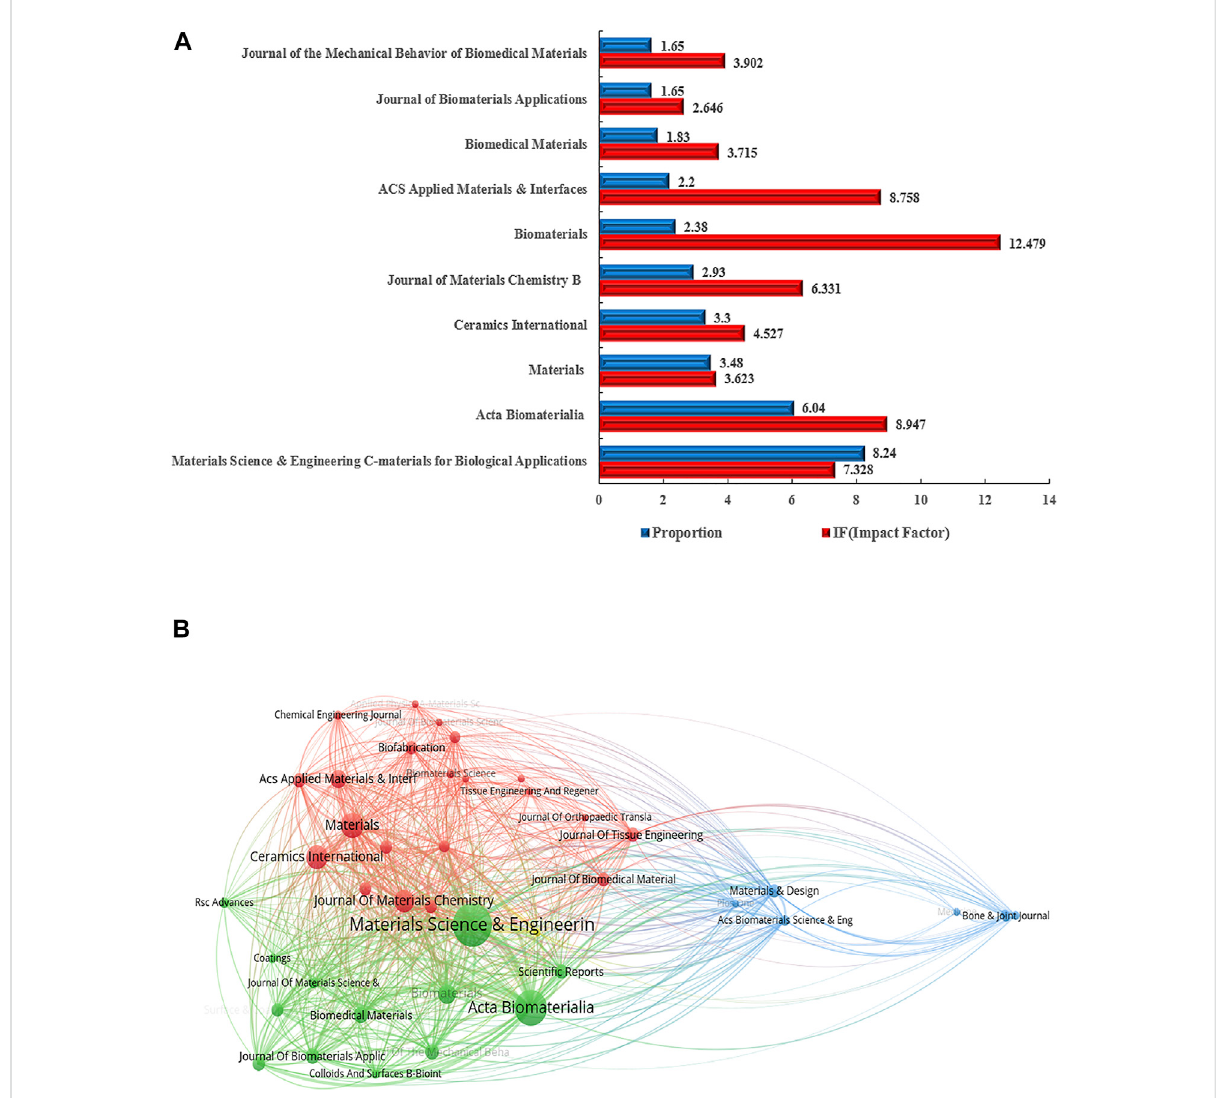
FIGURE 5 Distribution of institutions engaged in research on metal materials and bone repair. (A) Top 10 institutions by number of publications. The numbers represent the percentage of publications, and different colors represent different countries. (B) Network of institutions visualized in VOSviewer. The size of circles represents the number of